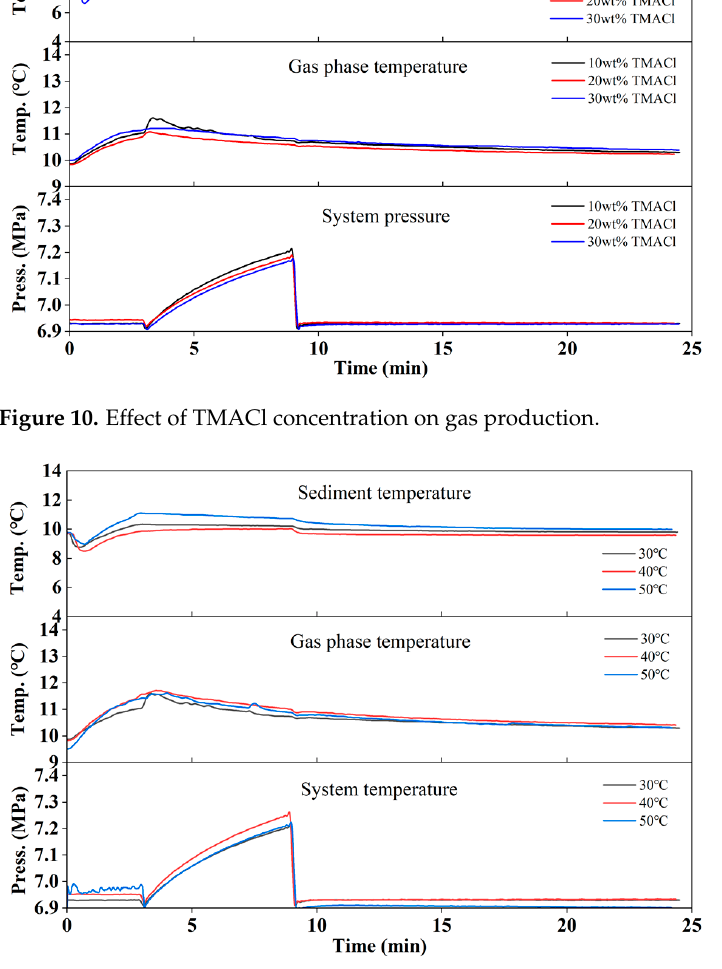
Figure 11. E ff ect of injection temperature of TMACl solution on gas production. Figure 11. Effect of injection temperature of TMACl solution on gas